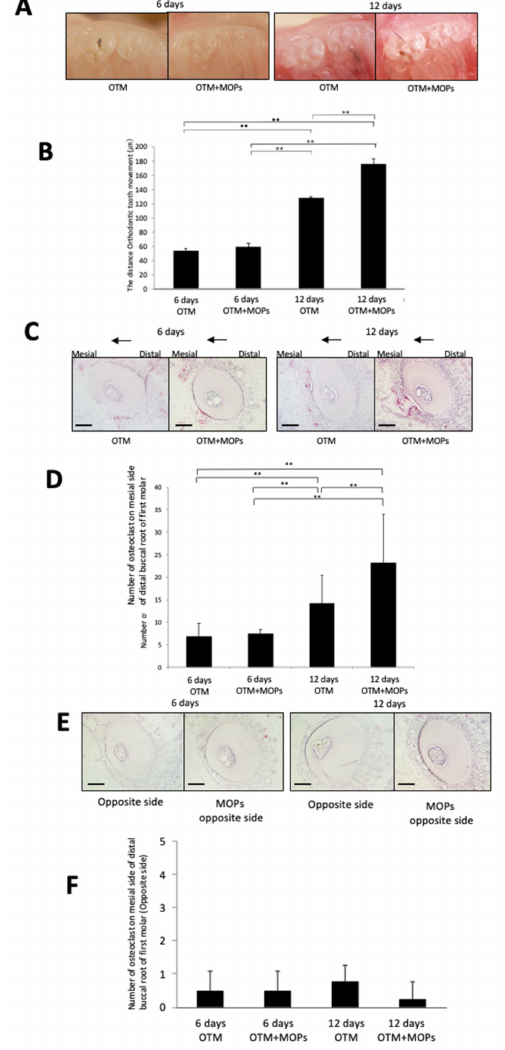
Figure 2. Effect of MOPs on orthodontic tooth movement and histology analysis of MOPs on orthodontic tooth movement: ( A ) Images of teeth after 0, 6 and 12 days of experimental loading with and without MOPs in WT mice. ( B ) Distance of tooth movement with and without MOPs in WT mice after 0, 6 and 12 days of experimental loading. ( C ) TRAP-stained histological sections of the distobuccal root of the maxillary left first molar after 6 and 12 days of experimental loading with and without MOPs in WT mice. Arrows indicate the direction of OTM. ( D ) Evaluation of the number of osteoclasts on the mesial side of the distobuccal upper-left first molar. ( E ) Histological examination was performed to evaluate the area affected by MOPs. TRAP-stained sections of the opposite side of WT mice with and without MOPs on Day 6 and Day 12. ( F ) The number of osteoclasts on the opposite side of WT mice with and without MOPs on Day 6 and Day 12. The results are presented as the mean ± standard deviation ( n = 4). ** p < 0.01 indicate significant differences, which were analyzed by using the Scheffe test. Scale bars = 100 µ